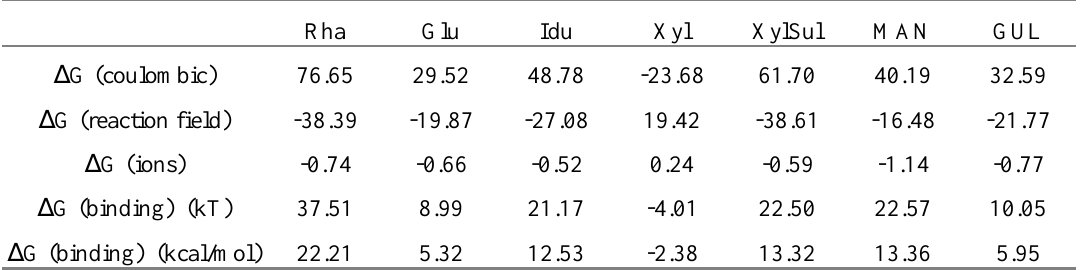
Table 6. Energetic contributions computed by DelPhi and involved in the D G calculation.